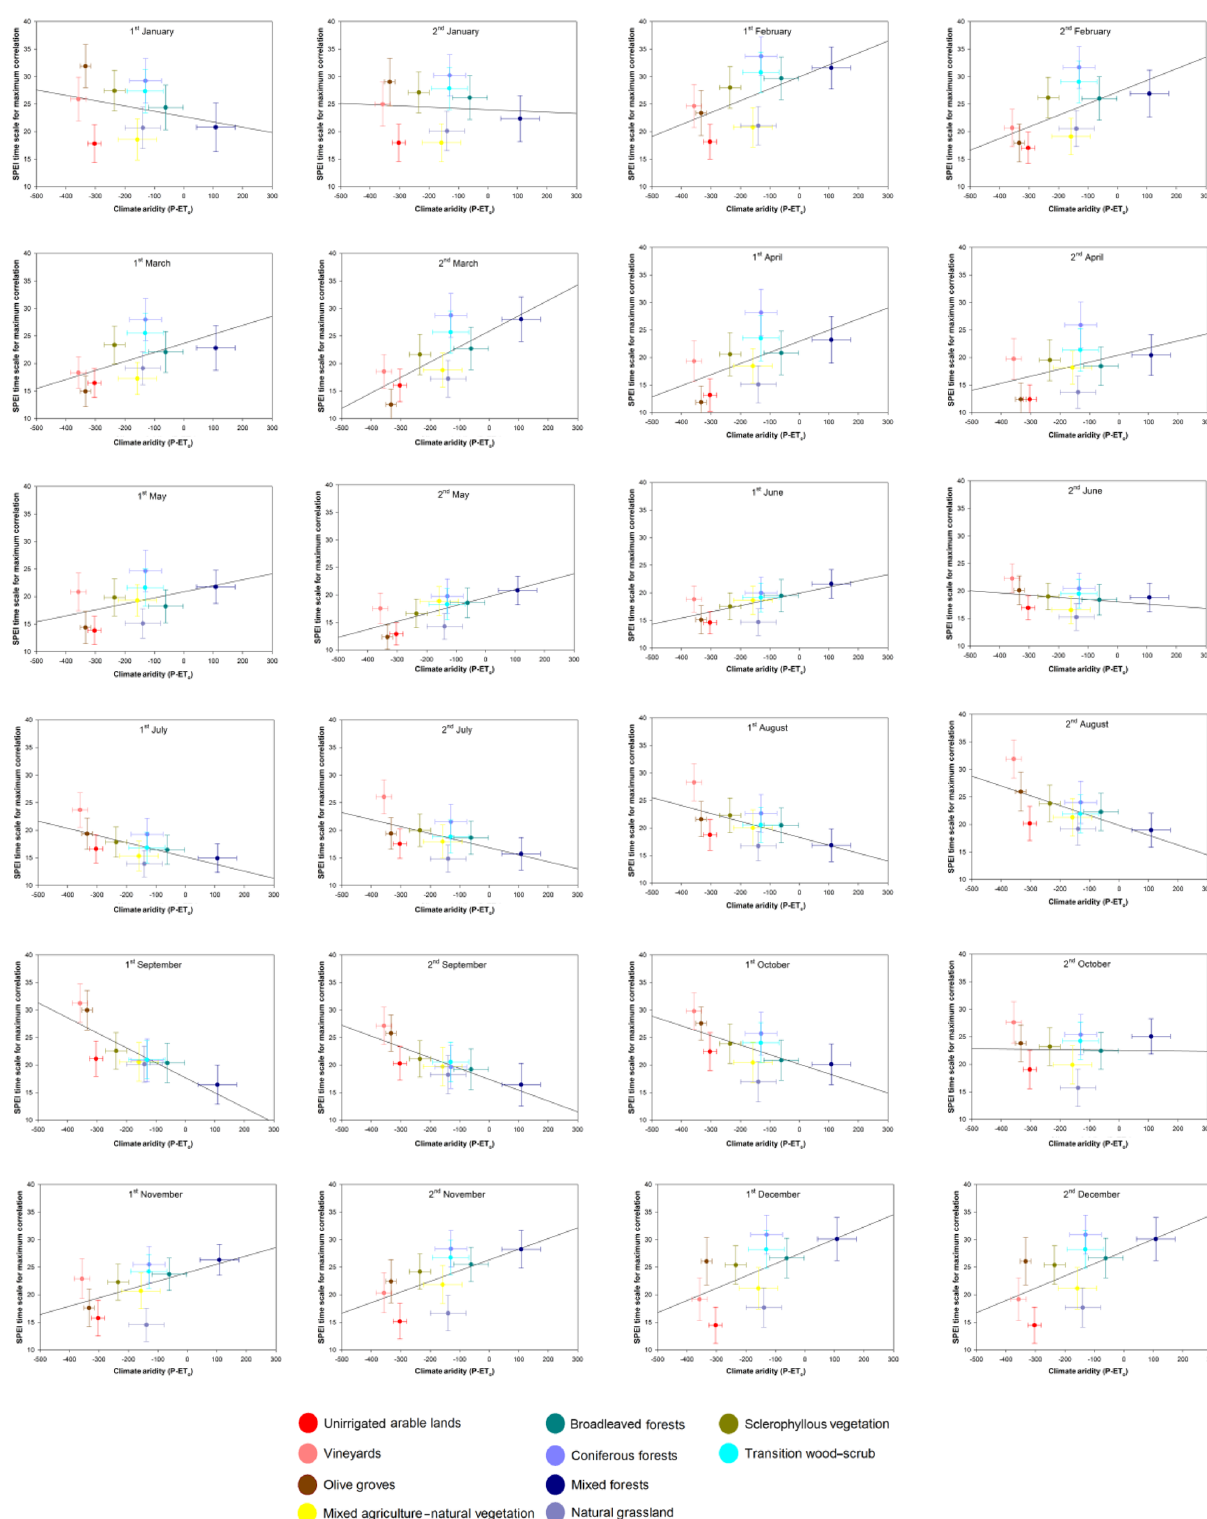
Figure 13. Scatterplots showing the relationship between the mean annual aridity and the SPEI timescale at which the maximum correlation is found between the sNDVI and SPEI for the different land cover types. Vertical and horizontal bars represent one-fourth the standard deviation around the mean